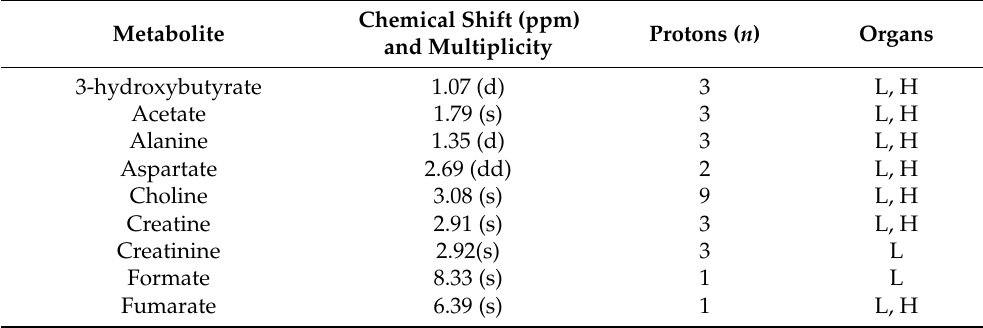
Table 6. 1 H-NMR chemical shift assignment for all quantified metabolites. For organ specification: L = liver, H = heart, and A = adipose